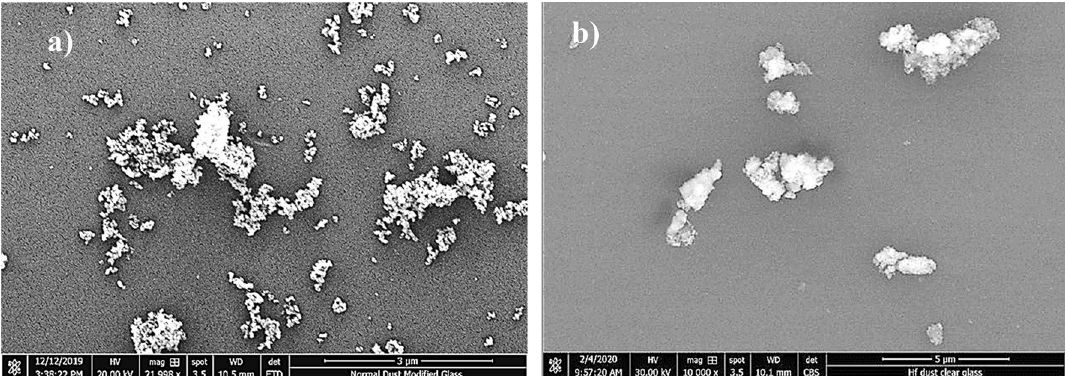
Figure 9. Dust residues on glass surface: ( a ) untreated dust, and ( b ) solution cured the glass surface. It is worth to mention that small dust particles possess large ionic forces, which cause strong adhesion on surfaces. This can be observed in Fig. 9a, in which SEM micrographs of dust remains (residues) on the glass surface are shown after dust mitigation. Also, SEM micrographs of solution cured dust residues on the glass surface after dust mitigation is also shown in Fig. 9b. In general, dust residues are small and scattered over the surface, which is more apparent for the solution cured dust case. However, untreated dust residues demon- strate the clustered-like structures on the glass surface. The energy-dispersive spectroscopic analysis shows that untreated dust residues possess the salt compounds with non-stoichiometric elemental ratios. Hence, the ionic forces developed on the dust particles contribute to the adhesion of these particles on the glass surface. Never- theless, dust residues do not cover the large area on the glass surface. In the case of solution cured dust residues, the size of the particles is small and energy dispersive spectroscopic analysis revealed that silicon content is high while no fluorine is observed in the cured dust residues. Therefore, few dust residues are not properly solution treated, which maybe because of the low concentration of diluted hydrofluoric acid treatment. To evaluate the area of the glass surface cleaned (dust mitigated) for untreated and solution treated dust cases, the ratio of dust mitigated surface area over the total surface area of the dusty glass surface is extracted from the high-speed camera images. Figure 10 shows optical images extracted from high-speed records for untreated and solution cured dust cases at the same inclination angle under the avalanche influence. Also, the image of untreated dust particles without avalanche influence at the same inclination angle is provided in Fig. 10 for comparison. The solution cured dust particles are mitigated in bulks under the avalanche influence and the coverage of the dust mitigated area remains significantly larger than that of the untreated dust under the avalanche influence. Hence, the interlocking of the solution cured dust particles to pull down the neighboring particles while causing clus- tered particles to mitigate from the surface. Contrarily, the mitigation of the untreated dust particles occurs along the ZrO down on the glass surface, their velocity increases and the force of inertia enhances the amount of dust particles mitigating in the neighbourhood path of the ZrO 2 particles, particularly in the region towards the glass end. This